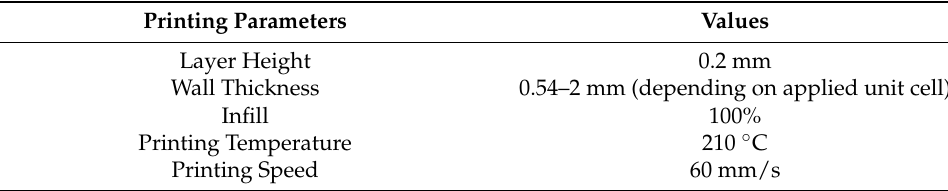
Table 2. General 3D printing parameters of all the TPMS